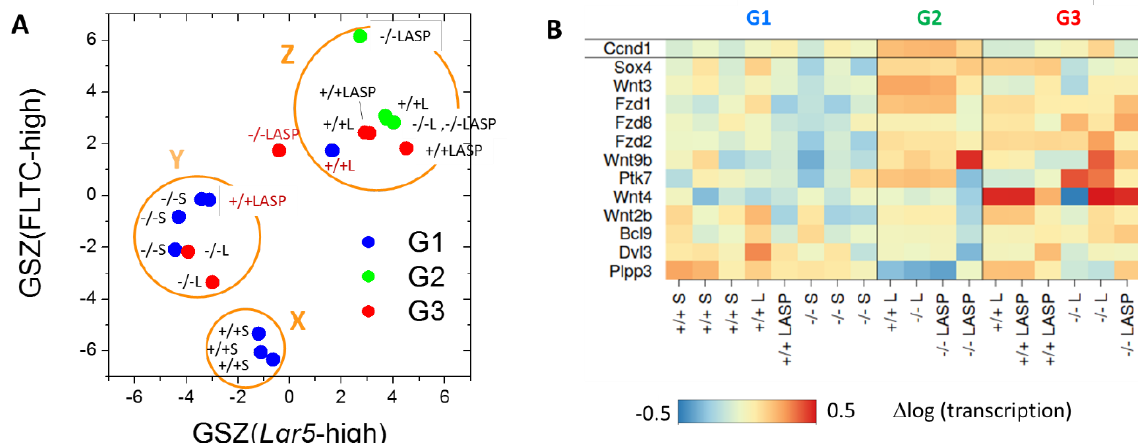
Figure 7. Evidence for maturation and metabolic changes in the long-term organoid culture. ( A ) The gene set Z (GSZ)-scores for Sets I ( Lgr5 -high) and II (FLTC-high) separate the samples from G1-3 into three regulatory states (X, Y and Z circles are to guide the eyes). States X and Y are occupied by G1 samples from Msh2 +/+ and Msh2 − / − mice, respectively. Samples that activate sets I and II during the long-term culture occupy state Z. This refers to the G2 samples and Msh2 +/+ mouse-derived G3 samples. The G3 samples derived from Msh2 − / − mice show no activation and occupy state Y. Brown labels indicate 3 samples not obeying these rules. ( B ) Heatmap of the transcription of the genes of the canonical Wnt signaling pathway (strongest regulated genes) and its target gene Ccnd1 . Activation of the Wnt pathway genes is seen in the long-term culture in general. However, only the G2 sample shows uniform target gene activation.